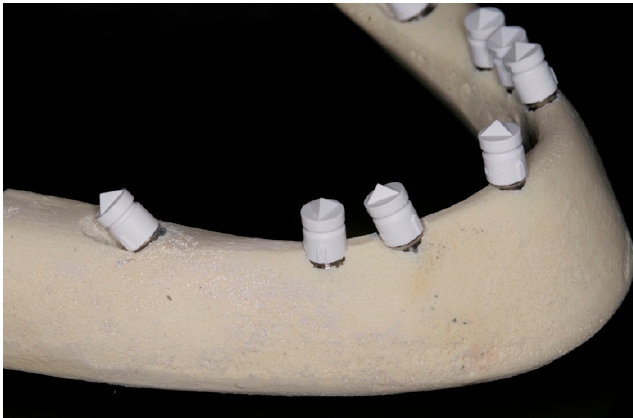
Figure 1. Working model with scan bodies attached to implants.